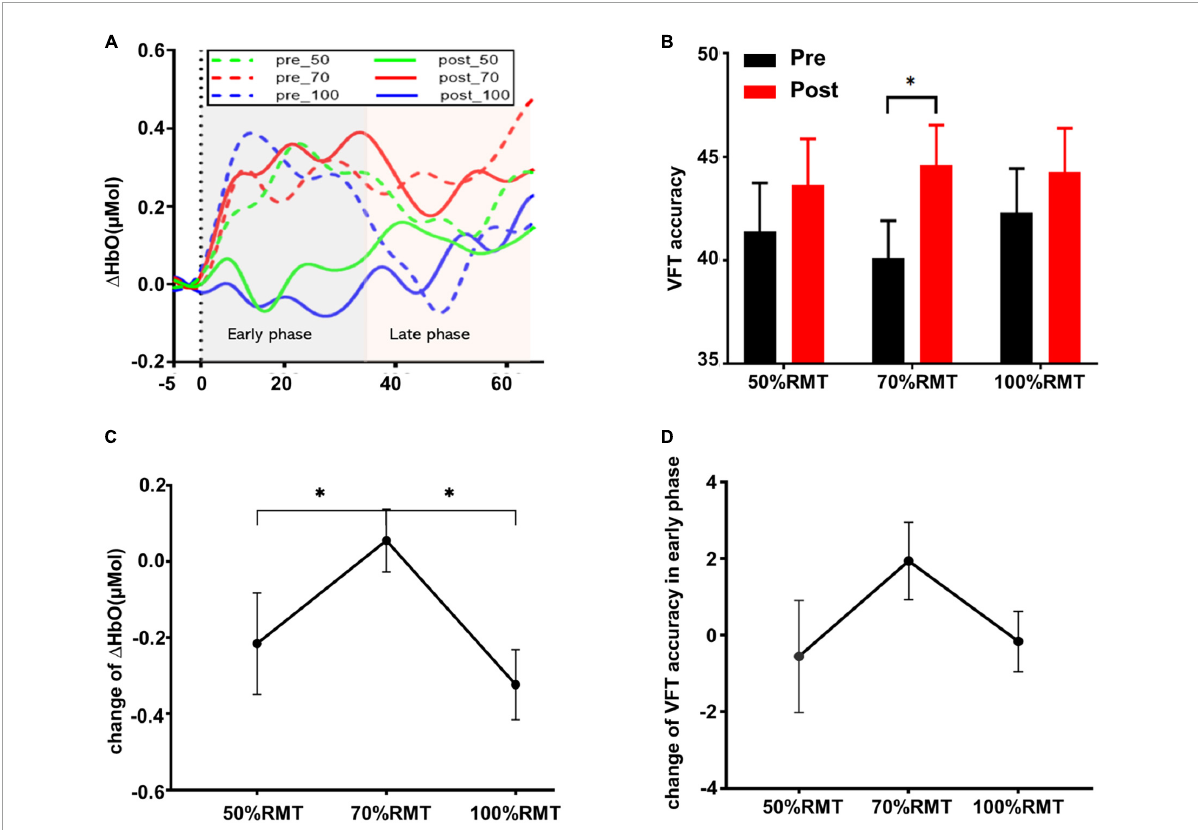
FIGURE3 (A) Group averaged time course HbO concentration change during the experimental condition in the left DLPFC (Ch28) before and after stimulation at each intensity. The Y -axis represents the mean of (cid:49) HbO. (B) VFT behavior performance (mean ± SEM) for the whole task period (0–60 s). (C) Change of (cid:49) HbO in the early task phase (0–30 s) for each stimulation intensity. Data were calculated by subtracting the mean of (cid:49) HbO before stimulation from the mean of (cid:49) HbO after stimulation. (D) VFT behavior performance change (mean ± SEM) in early task phase for each stimulation intensity. * p < 0.05.